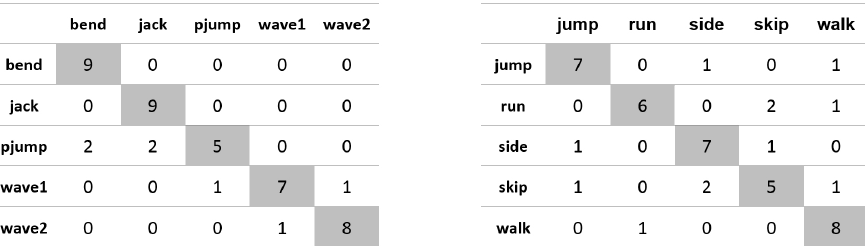
Figure A16. Confusion matrices for the experiment using the ‘lower-occlusion’ database, longerMBR and C1 correlation.